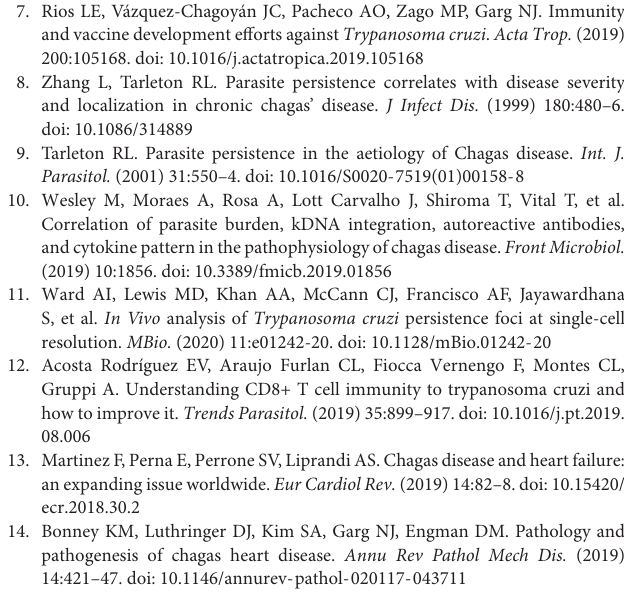
FIGURE S1 | Relationship between cardiac disfunction and IL-6. Spearman rank-order correlation test between ejection fraction (A) or shortening fraction (B) and mRNA expression levels of IL-6 in sera from uninfected, T. cruzi -infected and T. cruzi -infected and fenofibrate-treated WT and IL-10 KO mice were made. Spearman correlation coefficient is reported for each of the